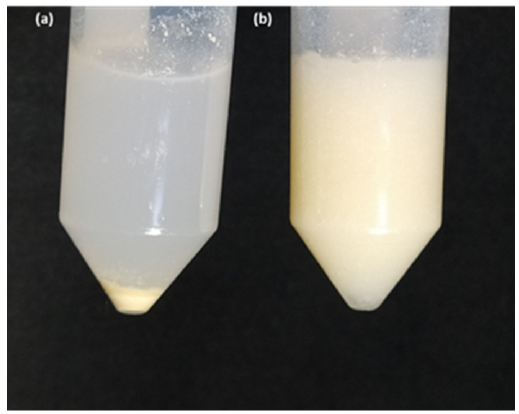
Figure 2. Suspension stability. ( a ) Flocculation of CZ in DW, ( b ) CNC/CZ improved suspension stability.